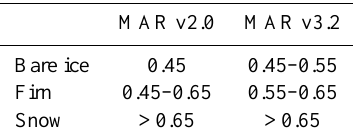
Table 1. Range of possible albedo values for different surface types in MAR v2.0 and